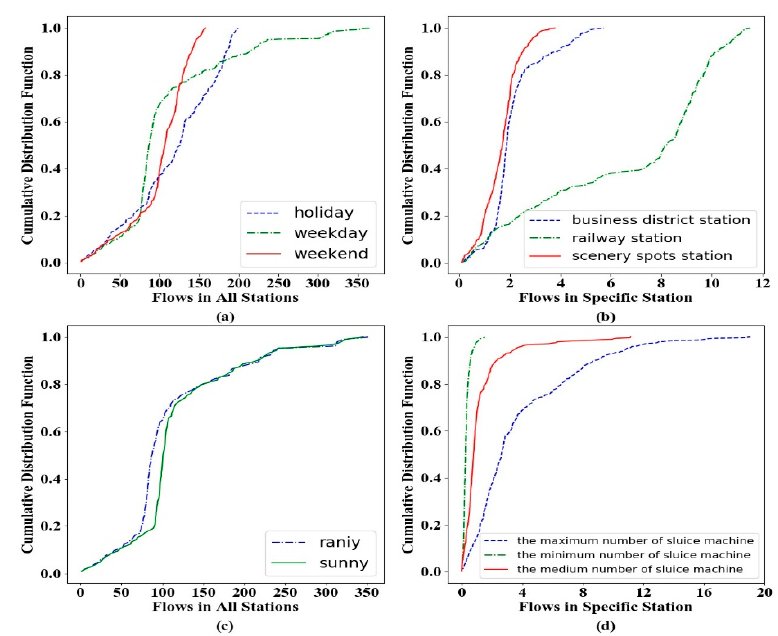
Figure 6. The CDF (cumulative distribution function) curve with solid and dotted lines represents the difference in traffic flow under various specific conditions, illustrating the effectiveness of several potential features that will be incorporated as external information. ( a ). Flows comparison on weekdays, holidays and weekends. ( b ). Flows comparison on business district station, railway station and scenery spots station. ( c ). Flows comparison between rainy and sunny. ( d ). Flows comparison among different numbers of sluice machine.